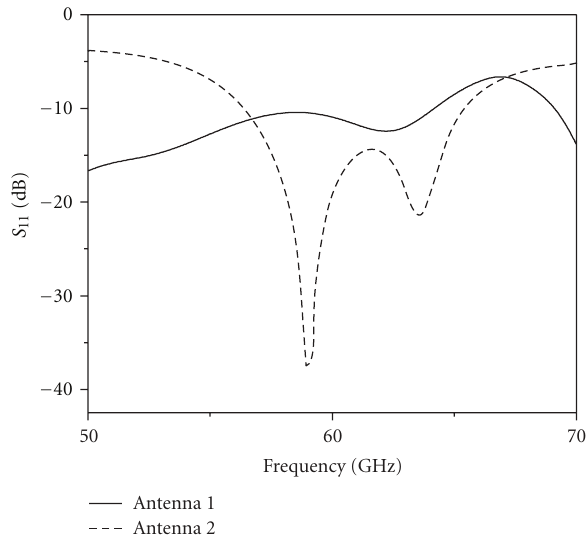
Figure 4: Reflection coe ffi cient magnitude for antenna 1 and antenna 2.